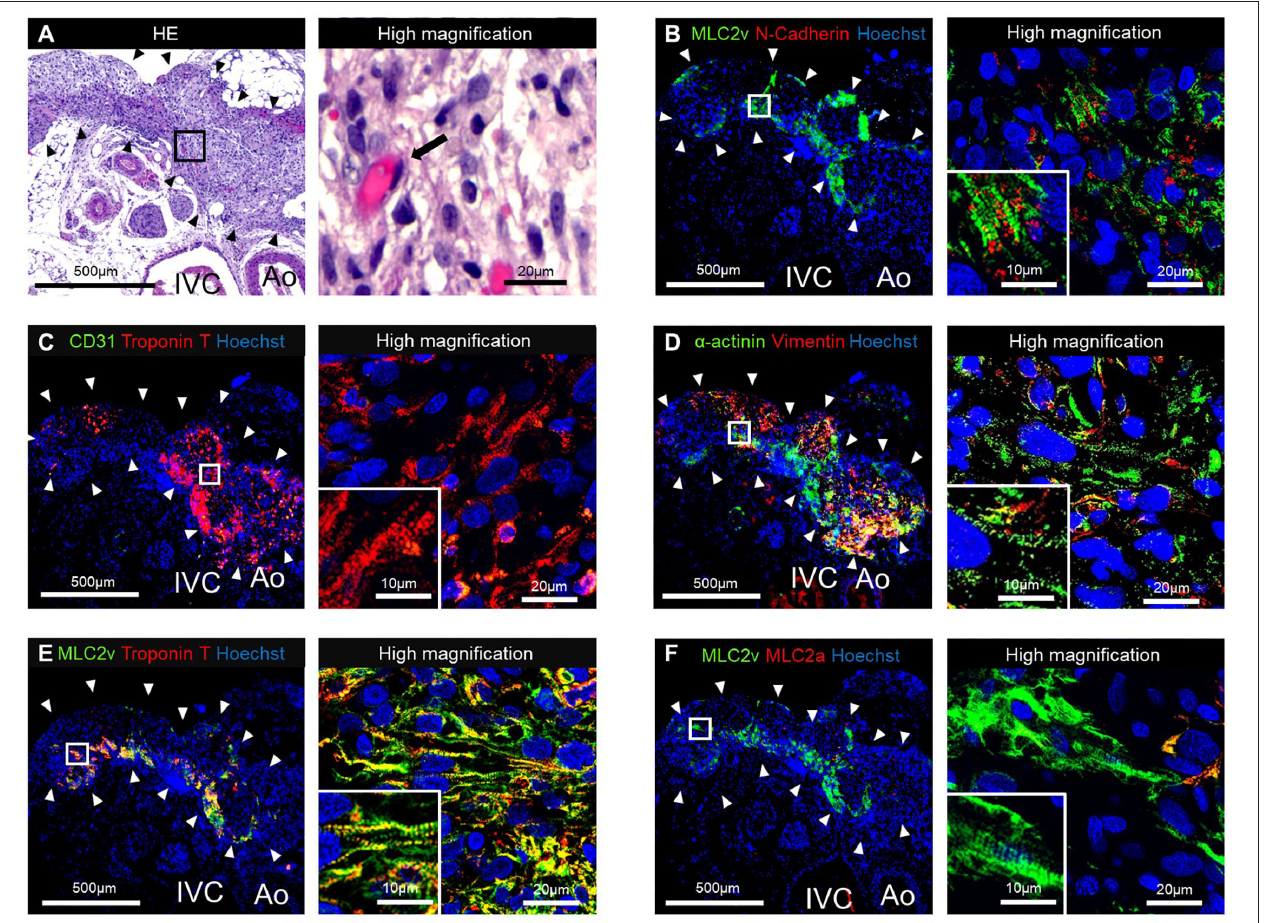
FIGURE 4 | Histological staining of the tubular engineered heart tissues (T-EHTs) and its high magnifications images after 1w of transplantation. (A) Hematoxylin and eosin (HE) staining. (B) Myosin light chain 2v (MLC2v) and N-cadherin. (C) CD31 and cardiac troponin T (cTnT). (D) α -actinin and vimentin. (E) MLC2v and cTnT. (F) MLC2v and myosin light chain 2a (MLC2a). The HE staining shows engraftment of the T-EHTs (black arrowheads) (A) . Red blood cells were found in the luminal structure with endothelial cells (black arrow). Immune staining reveals MLC2v-positive cells and N-cadherin-positive cells between them (B) . The cTnT-positive cells are found in the peripheral area of the tissue, and vimentin-positive cells are found in the middle (C,D) . Muscle striations are observed in MLC2a, MLC2v, and α -actinin staining (D–F)